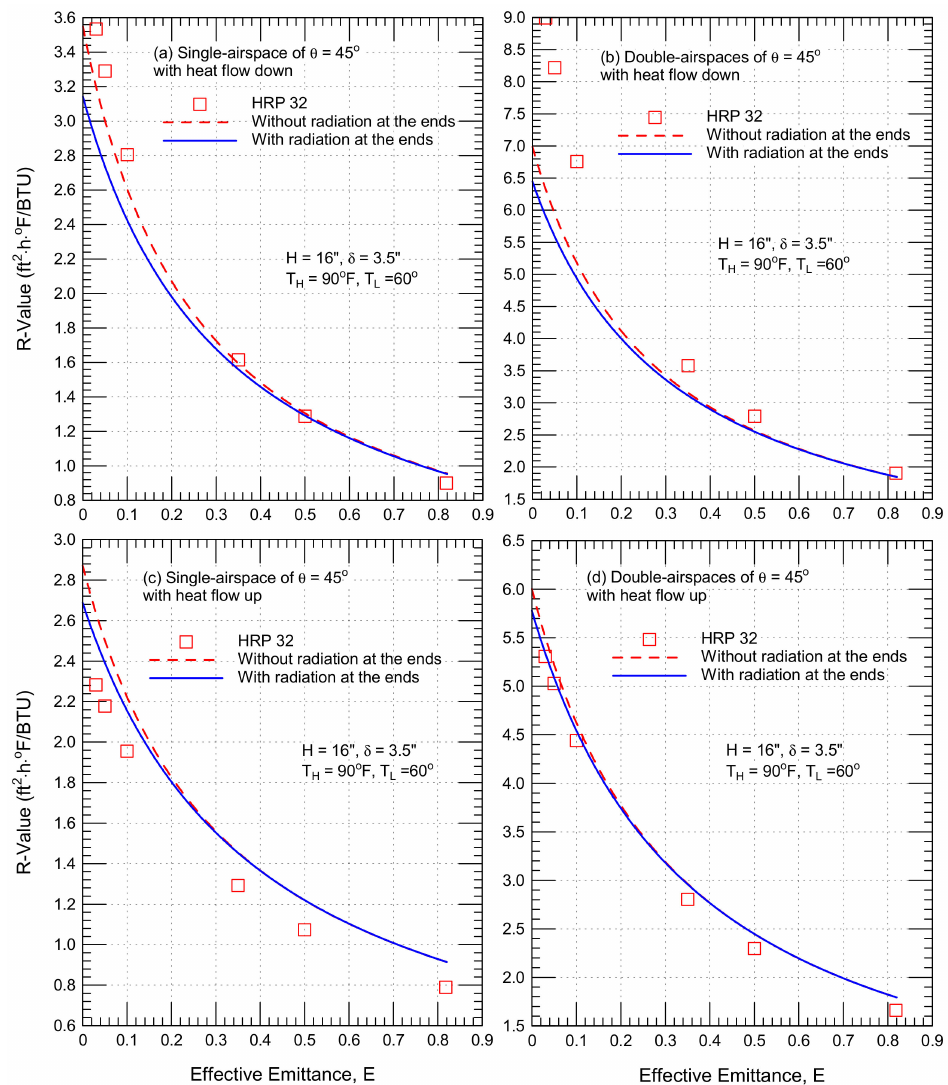
Figure 9. Effect of effective emittance on the thermal resistances of a sloped single airspace and double airspaces with end effect (i.e., ε 3 = 0.9) and without end effect (i.e., ε 3 = 0.0) of θ = 45 ◦ at H = 16 inches and total δ = 3.5 inches for a downward heat flow ( a , b ) and an upward heat flow ( c , d